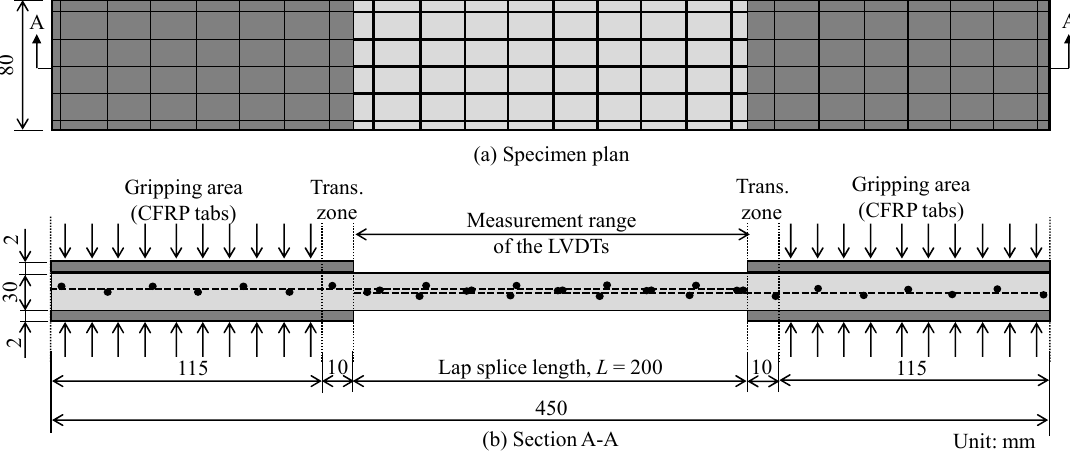
Figure 2. Configurations and details of the test coupons.